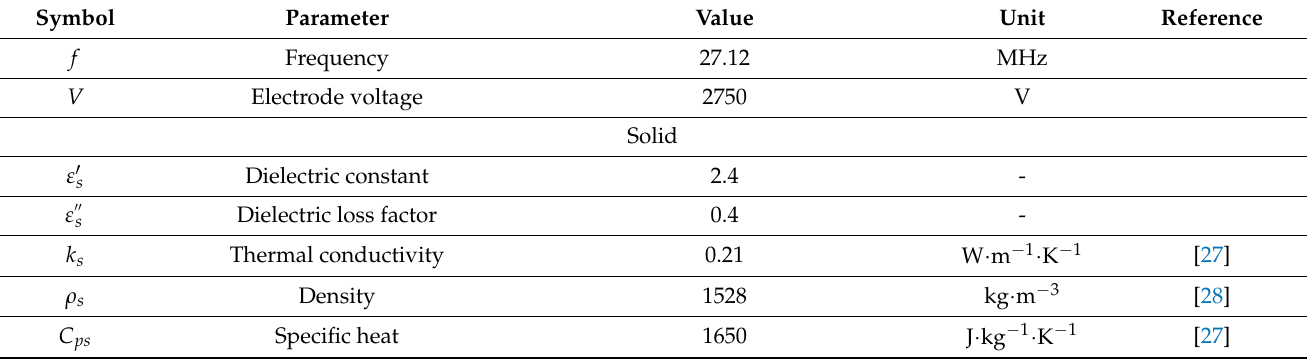
Table 1. Input parameters used in